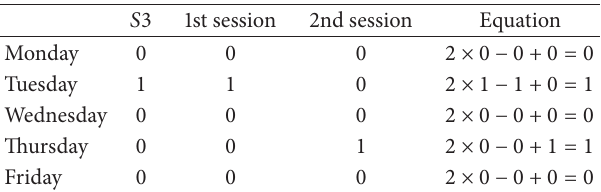
Table 7: 𝑆3 : variable equals 0 or 1. Table 8: Modelling